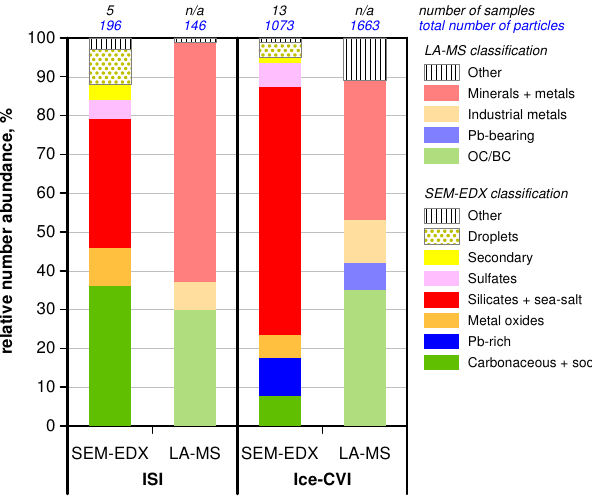
Figure 10. Comparison of particle class relative number abundance determined by SEM-EDX and LA-MS for IPRs sampled by ISI and Ice-CVI. To allow for a comparison of the two different analytical approaches of SEM-EDX and LA-MS, classes were combined ac- cordingly. For confidence intervals see Table S6 in the